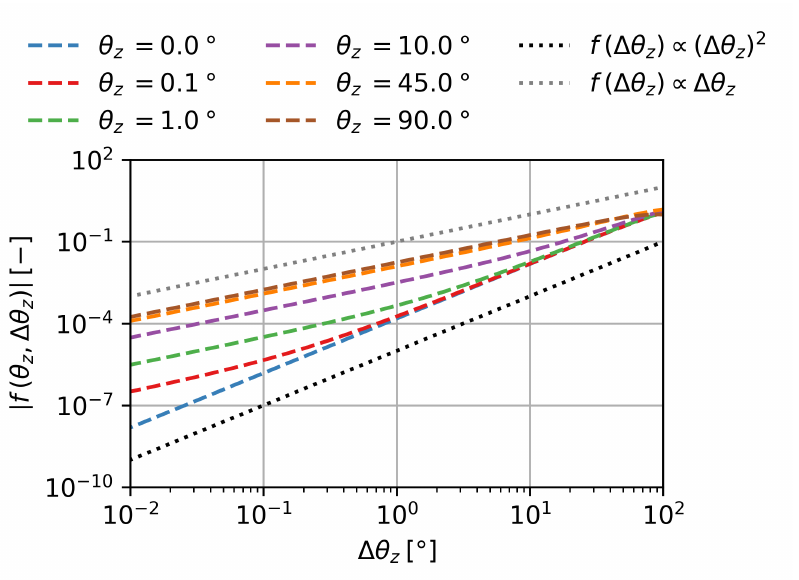
Figure 8. The subfunction f ( θ z , ∆ θ z ) = ( cos ( θ z + ∆ θ z ) − cos ( θ z )) for various θ z over ∆ θ z in double logarithmic